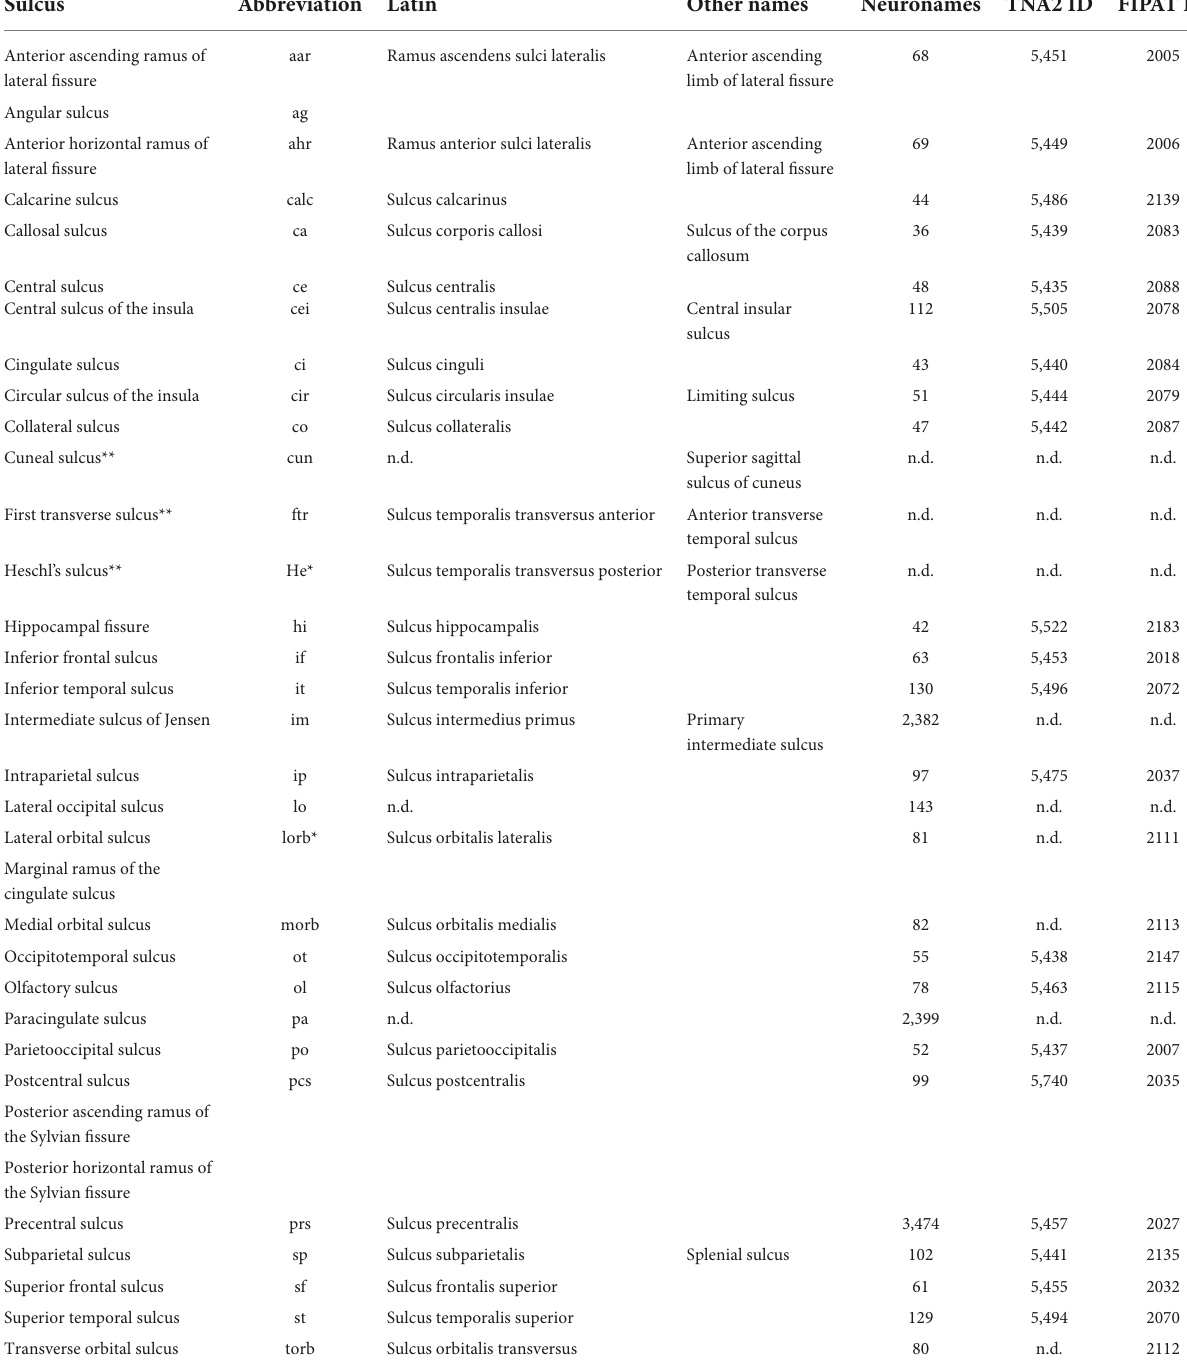
TABLE 3 Limiting sulci in the human Harvard-Oxford Atlas (hHOA).